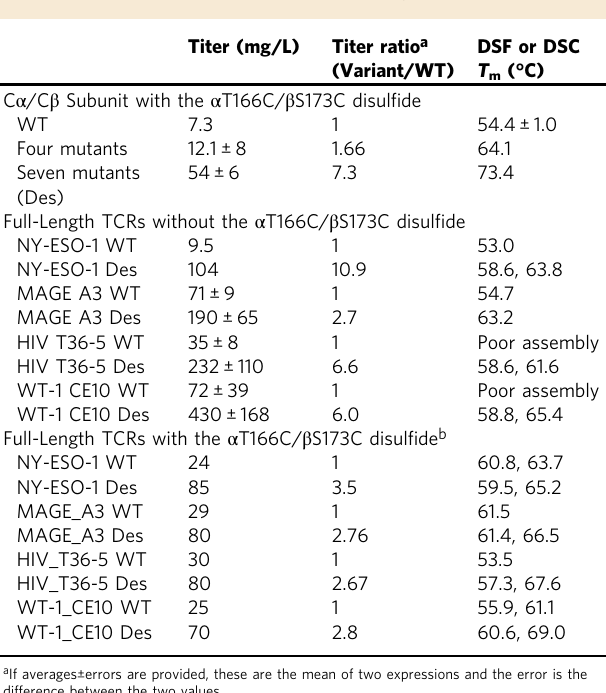
Table 1 Expression and thermal stability of wild-type (WT) TCRs and TCRs with the seven stabilizing mutations